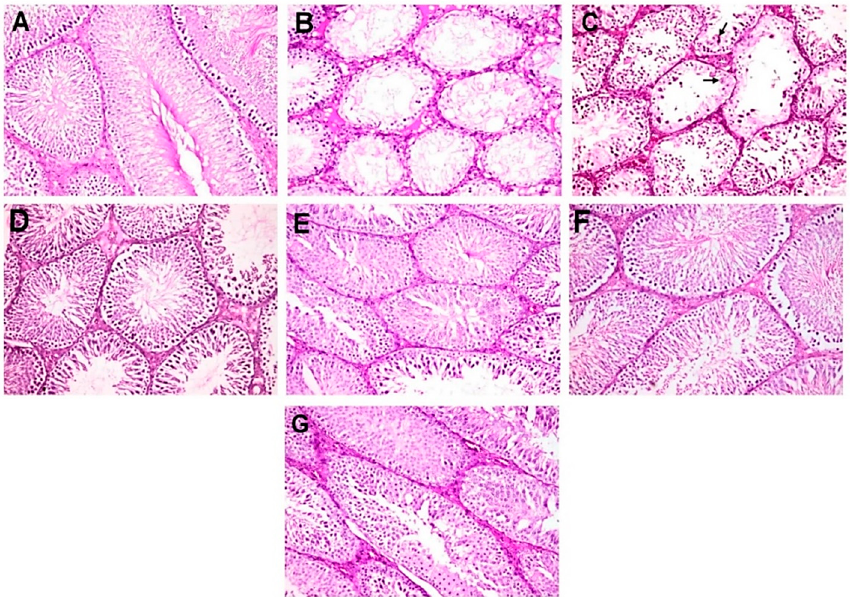
Figure 3. Photomicrographs of histopathological examination of testis (hematoxylin and eosin (H&E), 200 × ). ( A ) NC group showing normal histological picture of mature functioning seminiferous tubules. ( B , C ) DC group showing severe testicular degeneration with marked reduction or complete absence of spermatogenic cells with vacuolation of Sertoli cells, intertubular edema, and presence of spermatid giant cell (arrow). ( D , E ) D + MC-250 group showing restoration of normal architecture of seminiferous tubules with incomplete spermatogenic series. ( F , G ) D + MC-500 group showing restoration of normal architecture of seminiferous tubules with slight reduction in spermatogenic